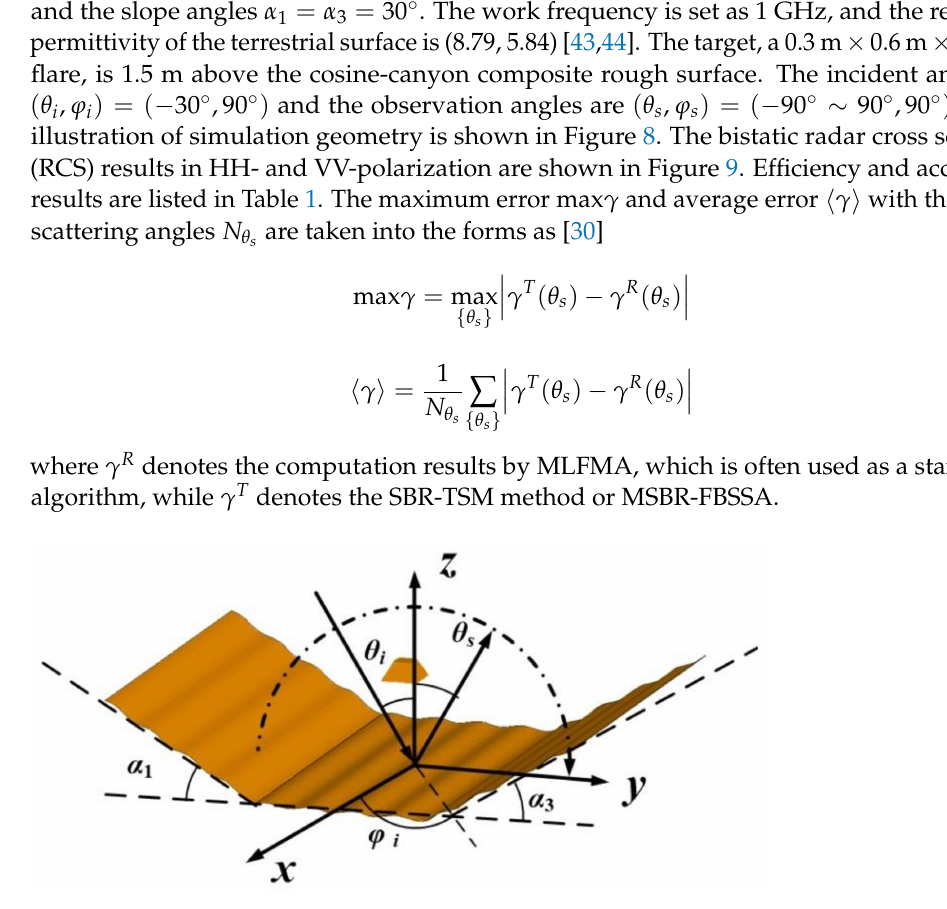
Figure 8. The geometry of a flare above the cosine-canyon composite rough